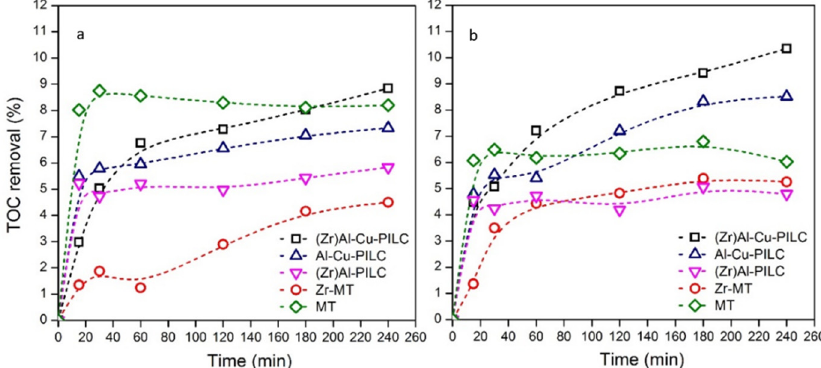
Figure 3. Evolution of TOC removal by adsorption: ( a ) pH 4.0 and ( b ) pH 7.0 (catalyst dosage = 3.0 g/L, [TOC] 0 = 500 mg C/L).